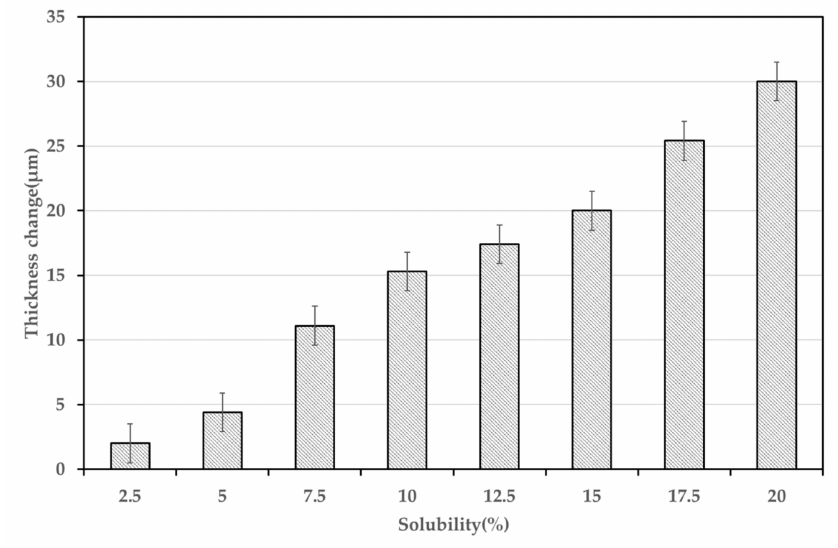
Figure 7. Average swelling depending on the solubility.